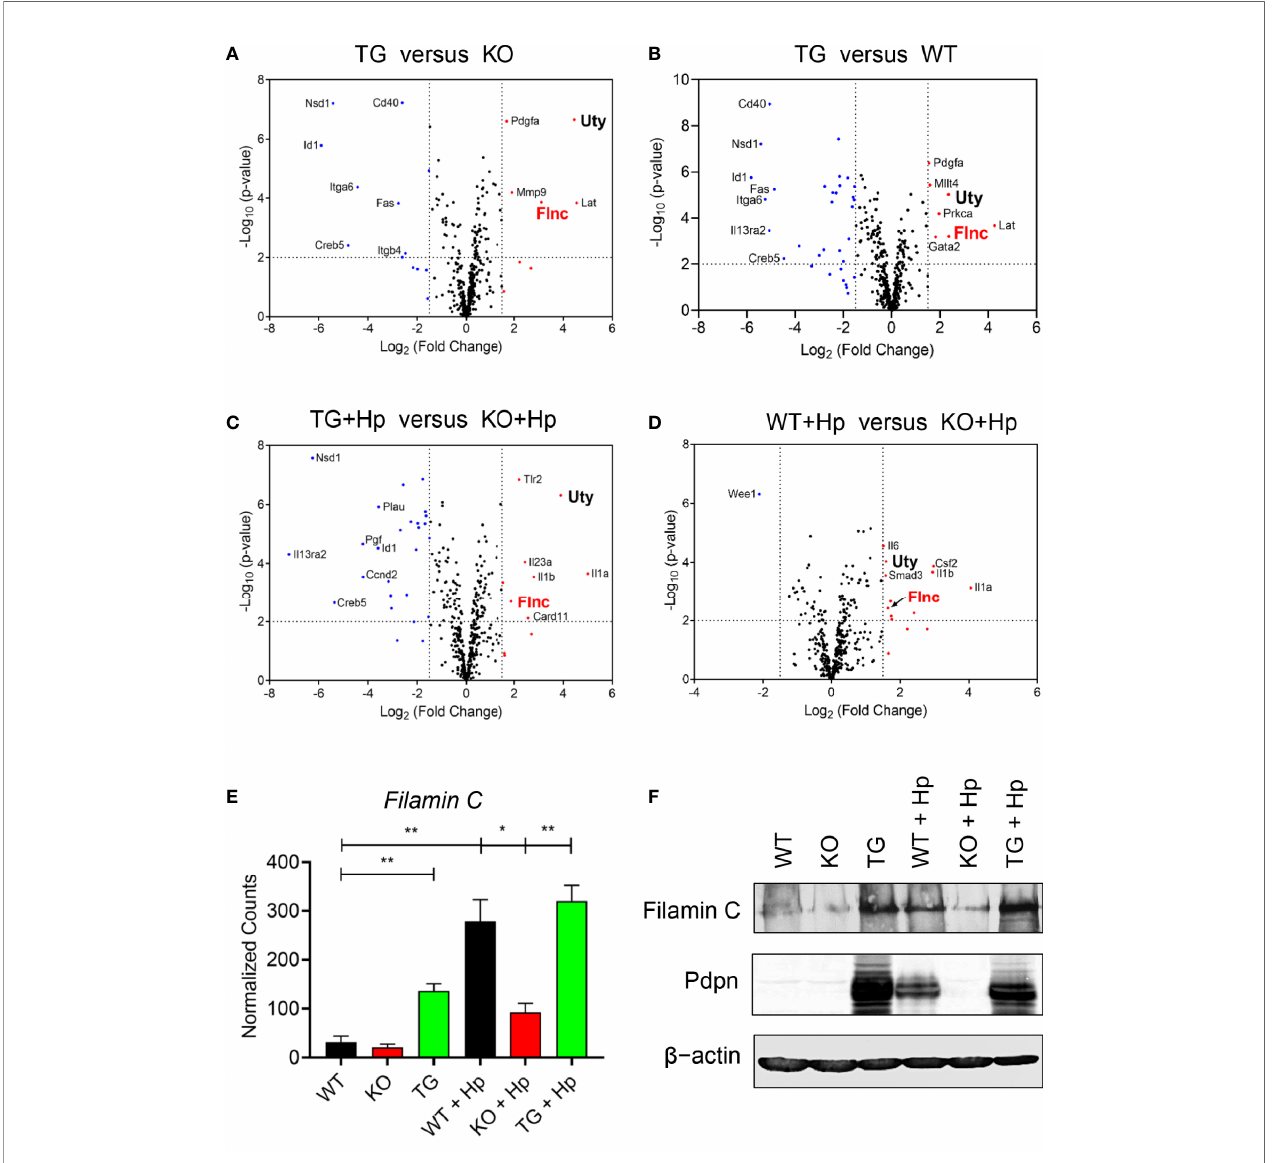
FIGURE 5 | Pdpn regulates the expression of Filamin C. (A – D) Volcano plots showing differential gene expression in groups of wild type (WT), Pdpn -knockout (KO) and Pdpn -transgenic (TG) cells before and after H. pylori infection at MOI 10 for 24 h (as indicated by +Hp). Comparison was made between the group with a high Pdpn expression versus the group without or with a lower Pdpn expression, as follows: (A) Pdpn -TG versus Pdpn -KO; (B) Pdpn -TG versus WT; (C) Activated Pdpn -TG versus activated KO; and (D) Activated WT versus activated Pdpn -KO. Note that a gene Filamin C ( FlnC ) was repetitively shown in all four groups of comparison, indicating its consistent upregulation by high Pdpn expression. Vertically broken lines demarcate log 2 (fold change) at >1.5 or < − 1.5. Horizontally broken lines demarcate statistical signi fi cance ( − log 10 p -value > 2, or p < 0.01) by R-based program in nSolver Advanced Analysis 2.0 software. Signi fi cantly upregulated and downregulated genes were highlighted in red and blue dots, respectively. (E) Bar charts show normalized RNA transcript counts of Filamin C from NanoString analysis. Data are shown as mean ± SD of biological duplicate samples. Statistical signi fi cance by unpaired Student ’ s t -test ( *p ≤ 0.05; ** p ≤ 0.01). (F) Immunoblot analysis of Filamin C Cell lysate from the uninfected or H. pylori (MOI 10, 24 h)-infected WT, Pdpn -KO, and Pdpn -TG cells were examined. Membranes were probed with antibodies to Filamin C, Pdpn, and b -actin as loading control. Data shown are representative data of two independent